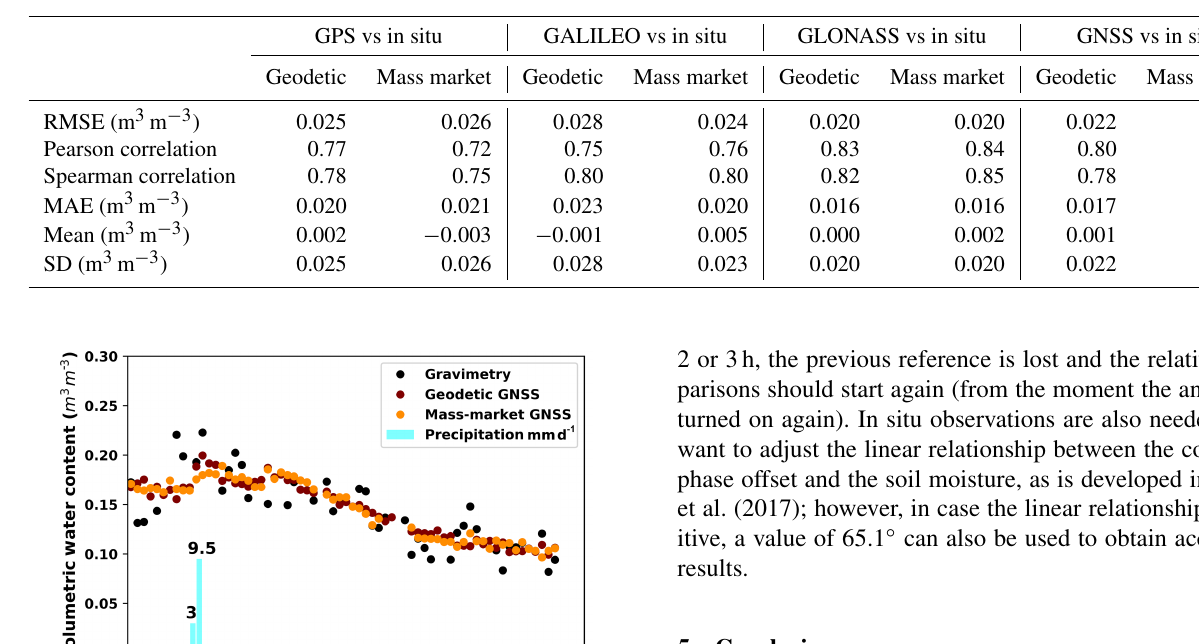
Table 2. Statistical summary of the soil moisture estimates from the GPS, GALILEO, and GLONASS constellations with the reference (in situ) values. GNSS is the combination of the three constellations. RMSE is the root mean square error, MAE is the mean absolute error, and SD is the standard deviation of the differences.